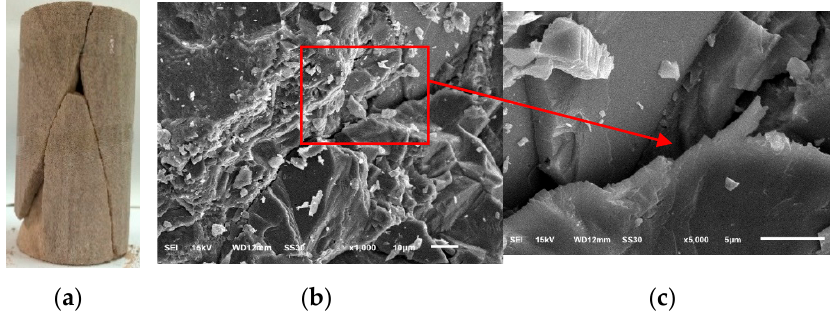
Figure 9. Failed sandstone specimens ( a ) and SEM images of microcracks in the specimen under uniaxial compression ( b , c ).